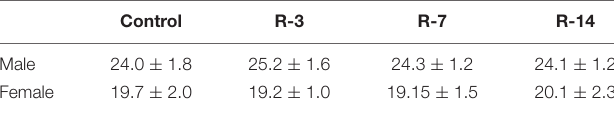
TABLE 2 | Animals body weight